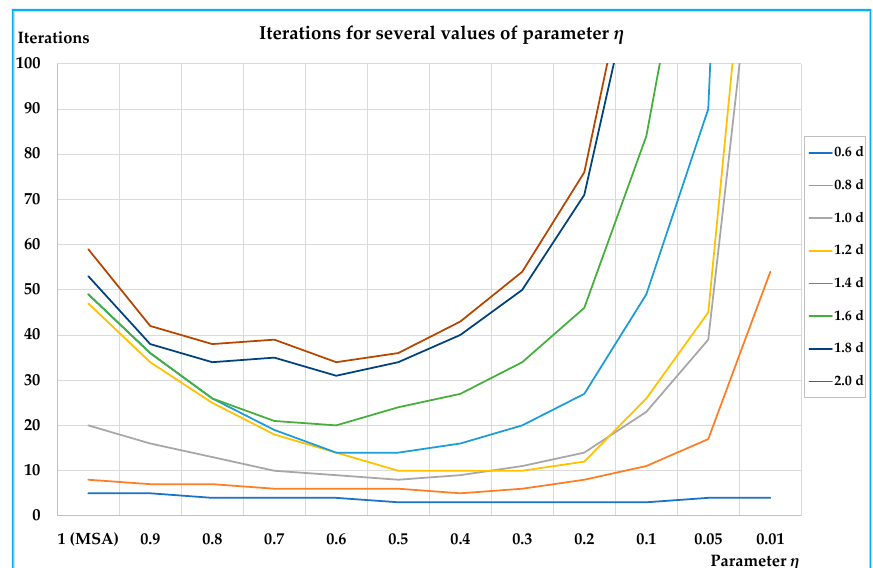
Figure 6. Results on the urban real-scale network ( C v = 0.05).